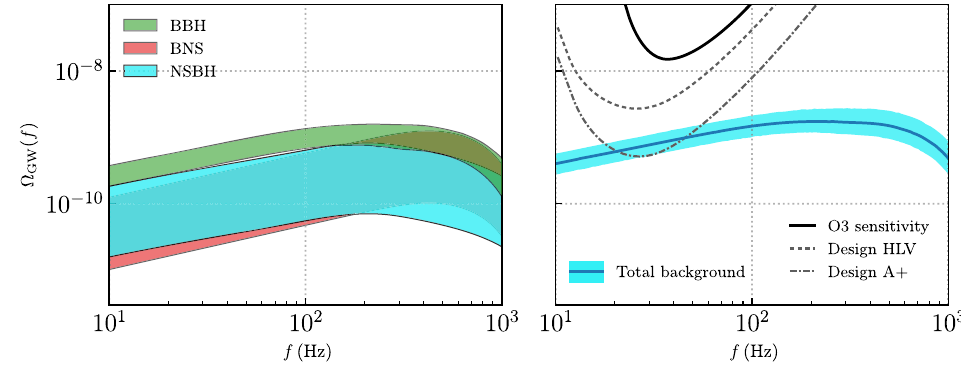
FIG. 23. Forecast of astrophysical gravitational-wave background due to binary mergers following O3. Left: the individual contributions expected from BNS, NSBH, and BBH mergers. While uncertainties on the energy density due to BNS and NSBH are due to Poisson uncertainties in their merger rates, our forecast for the stochastic background due to BBHs additionally includes systematic uncertainties associated with their imperfectly known mass distribution. Right: estimate of the total gravitational-wave background (blue), as well as our experimental current sensitivity (solid black) [228,357]. For comparison, we additionally show the expected sensitivities of the LIGO-Virgo network at design sensitivity, as well as that of LIGO ’ s anticipated A þ